Question: Write a single sentence explaining what this figure depicts.
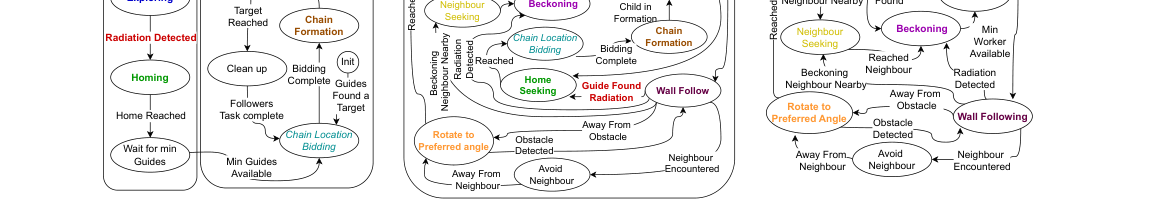
Answer: The set of behaviors performed by the robots during the three control approaches: In Hierarchical, the guides explore to identify the targets (A), on identification of the target they return home (D), and form a chain to transport the workers to the target (G). During Heterogeneous control, the exploration is performed by both guides and workers using their sensing abilities (B), on identification of target guides return home with broadcasts of target identification, workers receiving the broadcasts return home (E), and the workers are transported to the target in chain formation (H). In Egalitarian, all the robots explore using bug-inspired algorithm (10) (C), robot create beacons around the target to attract other bugs (F), and the radiation cleanup task is performed after the required number of robots reach the target (I). The overall mission of the robots is to identify the target, and navigate all the robots to its location. The state machine in (J-L) shows the sequentia